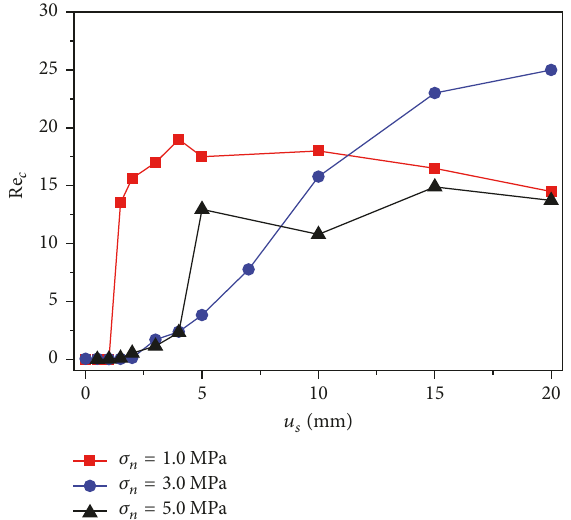
𝑢 𝑐 and 𝑠 based on the data replotted from Javadi et al. ([90], Figure 8